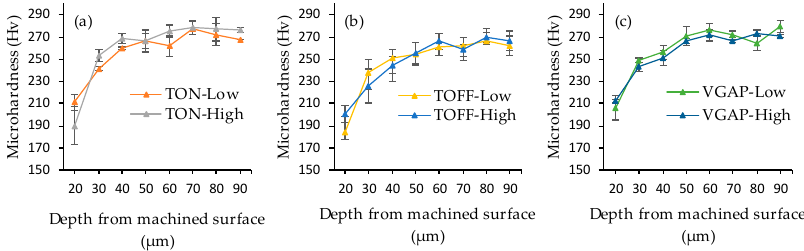
Figure 11. WEDM machined Sub-surface microhardness indents.